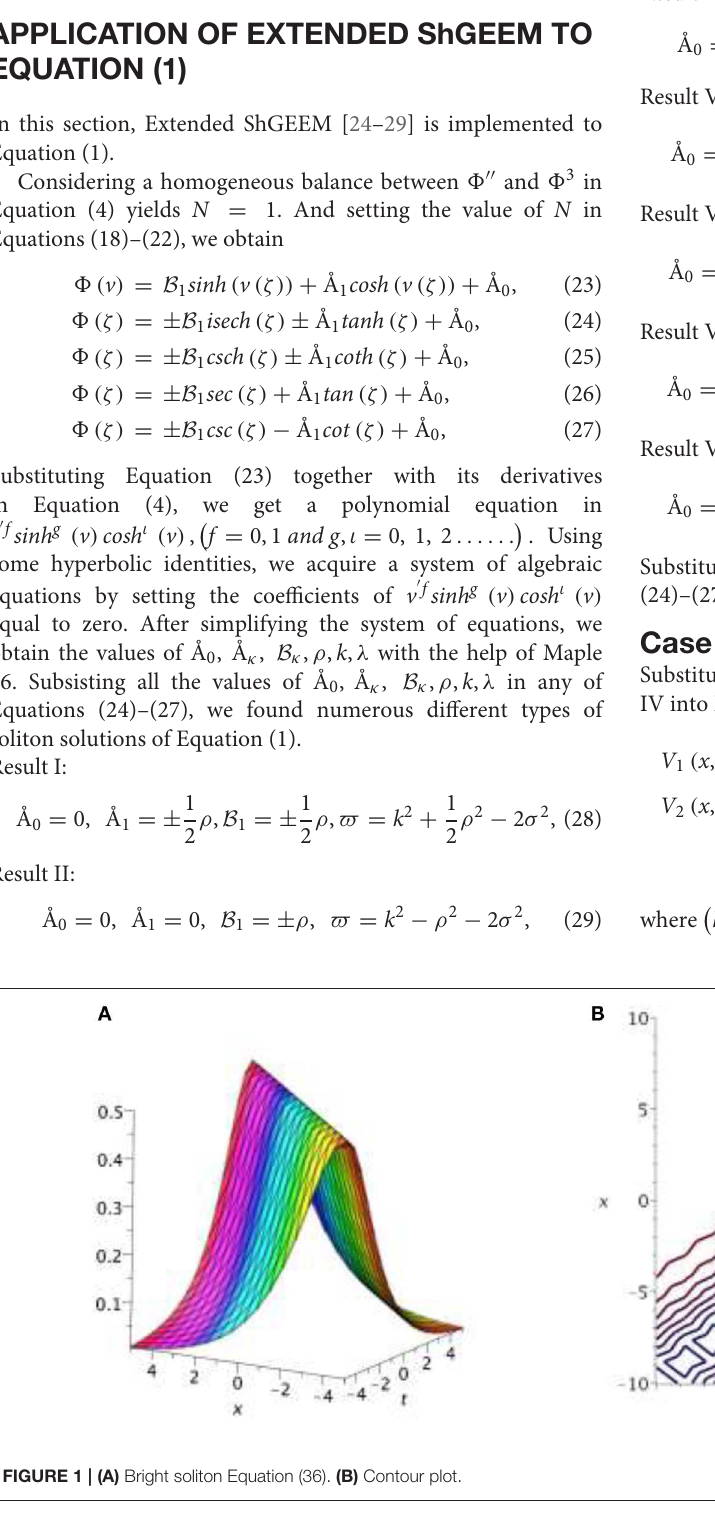
Frontiers in Physics |